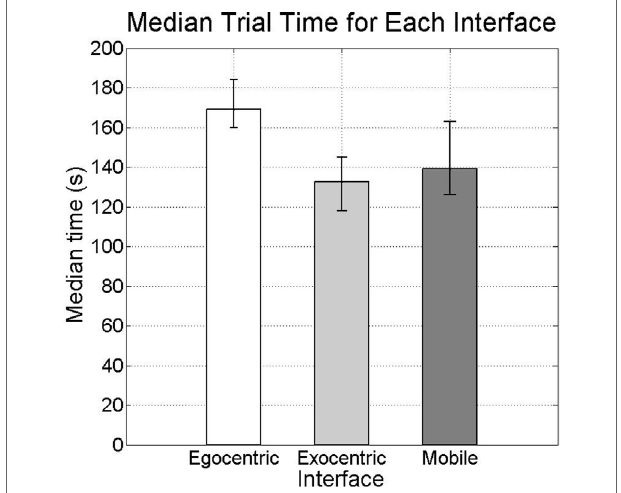
FigUre 11 | average amount of time spent performing the object manipulation task with each interface